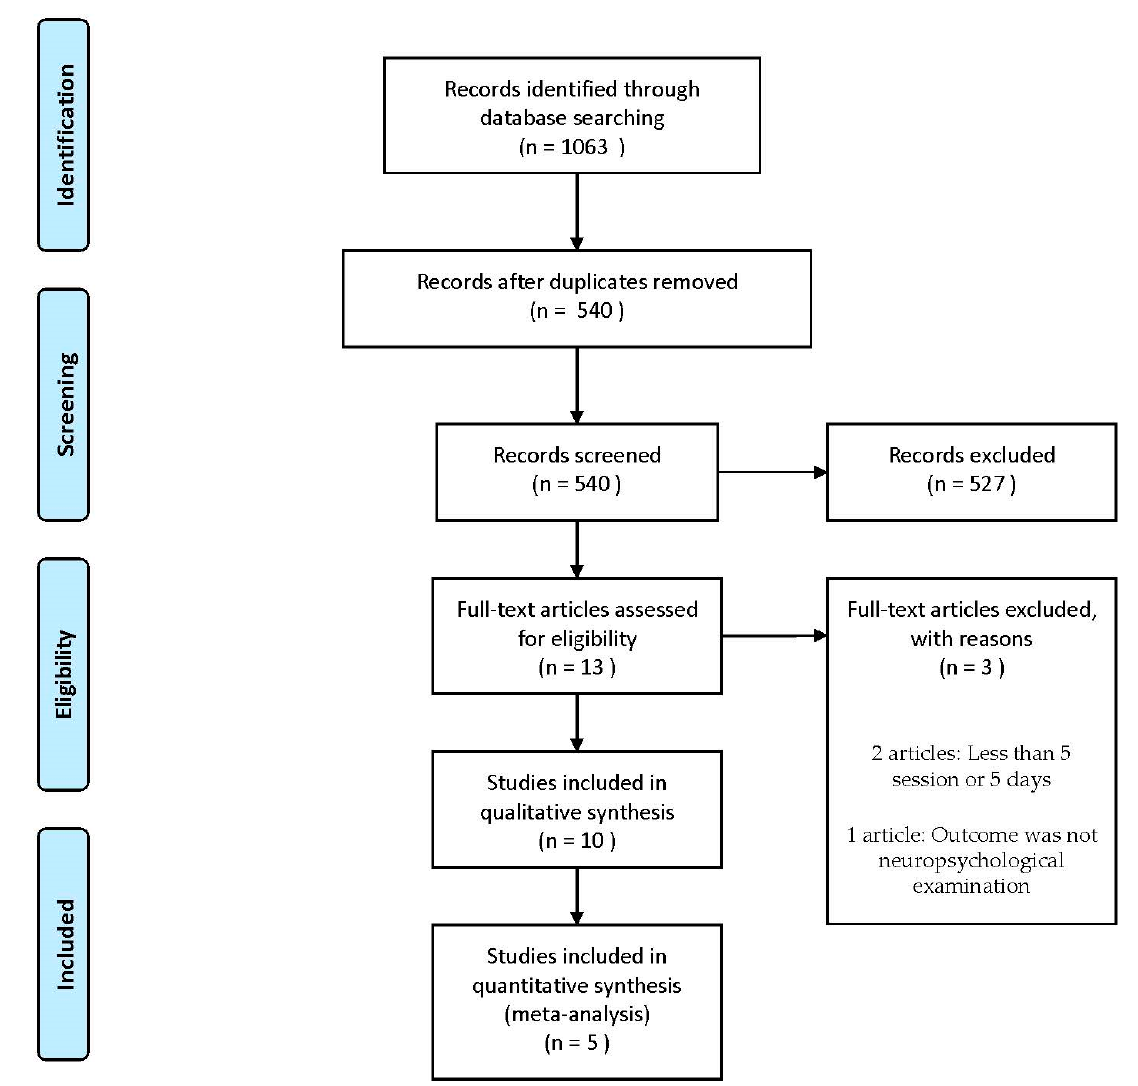
Figure 1. Study flow diagram.